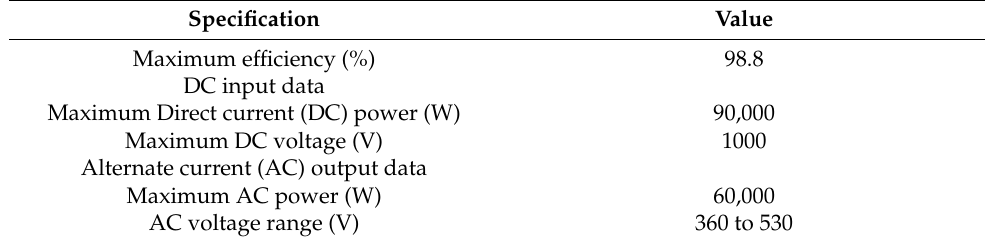
Table 2. Specifications for SUNNY TRIPOWER 60 invertor.